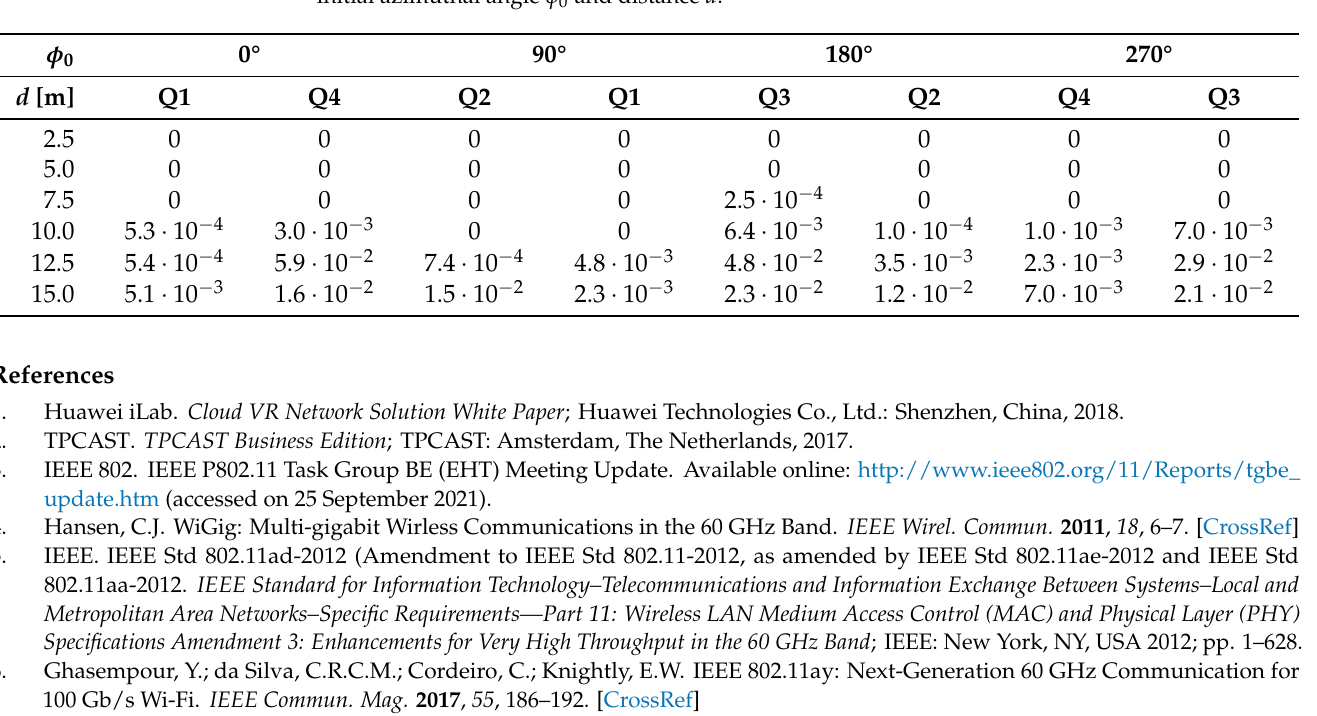
Table A2. Contributions to the freeze intensities for each quadrant per experiment, described by initial azimuthal angle φ 0 and distance d